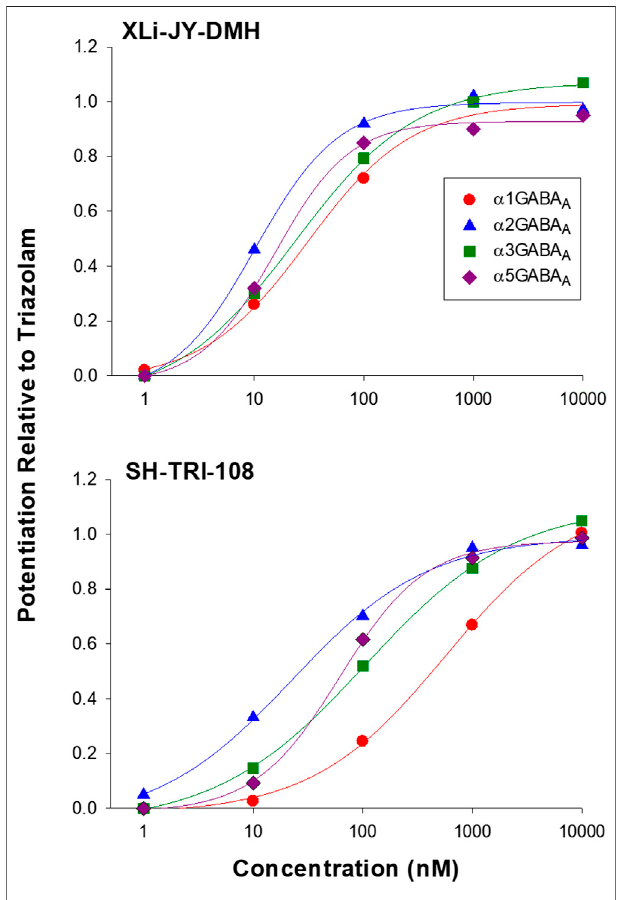
FIGURE 2 | Modulation of recombinant α xGABA A subtypes by 8- substituted triazolobenzodiazepines XLi-JY-DMH and SH-TRI-108. Data are expressed aspercentageoftriazolameffectsateachconcentration,basedon modulation of the ability of GABA (EC 3 ) to potentiate Cl − currents measured via patch-clamp techniques. Each point is based on N (cid:1) 3-5 replications.